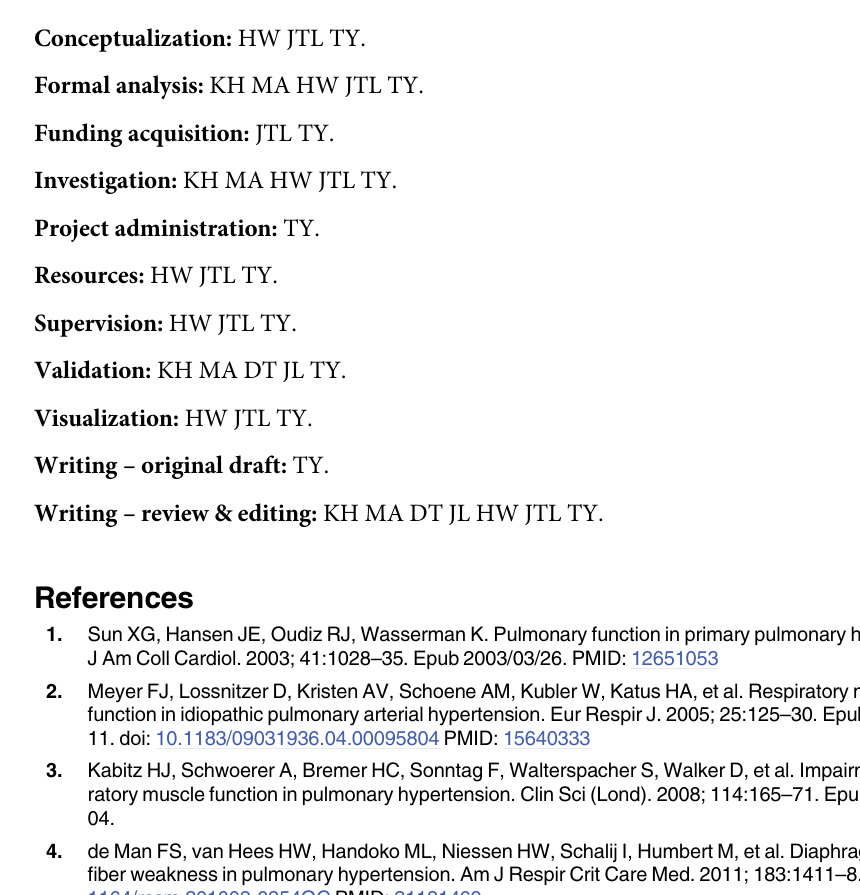
S1 Fig. EUK-134 does not alter diaphragm contractile function in normal rats. Specific force-frequency relationship in diaphragm fiber bundles from control (CNT) rats with or without EUK-134 (EUK) treatment. Data show mean ± SD for 6 muscles in each group.